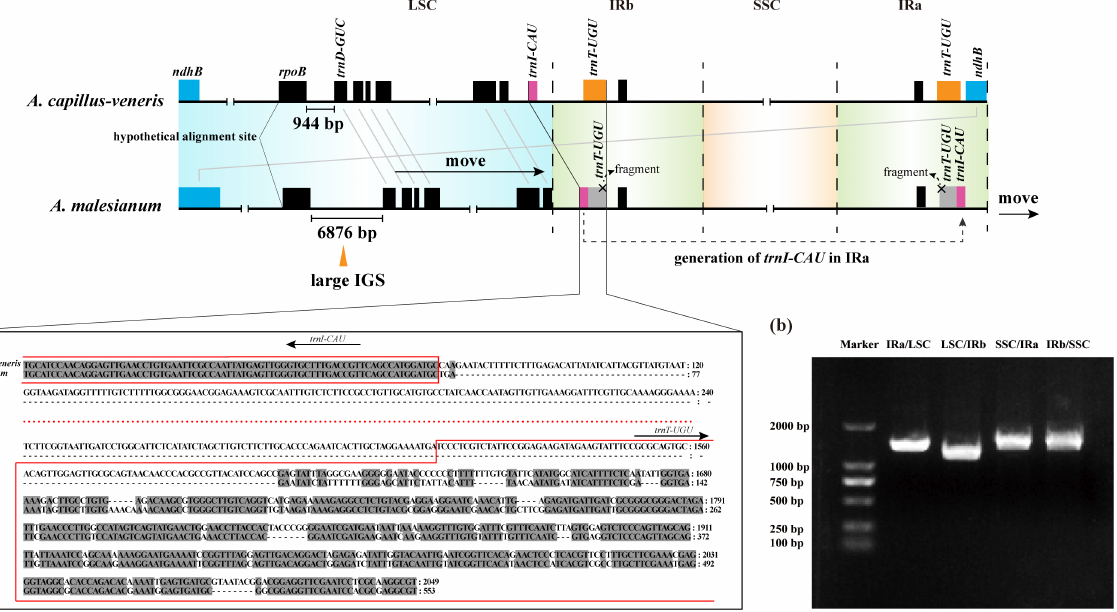
Figure 5. Figure 5.